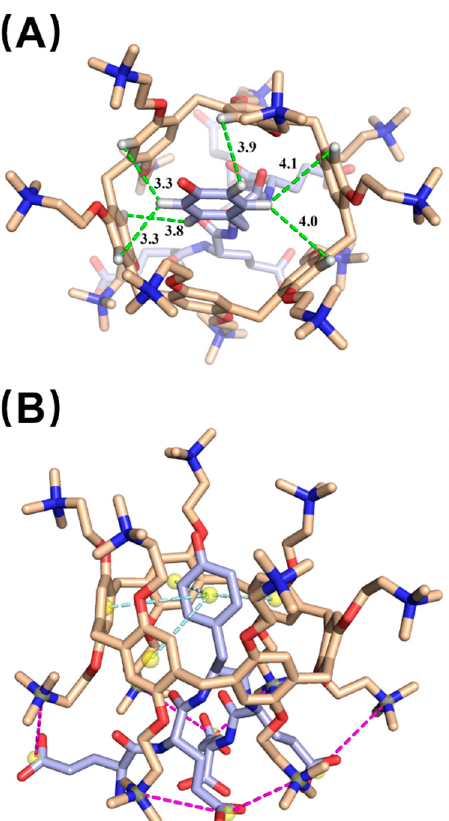
Figure 5. Conformation of the pEY / cPA6 complex by molecular docking: ( A ) top view; ( B ) side view.